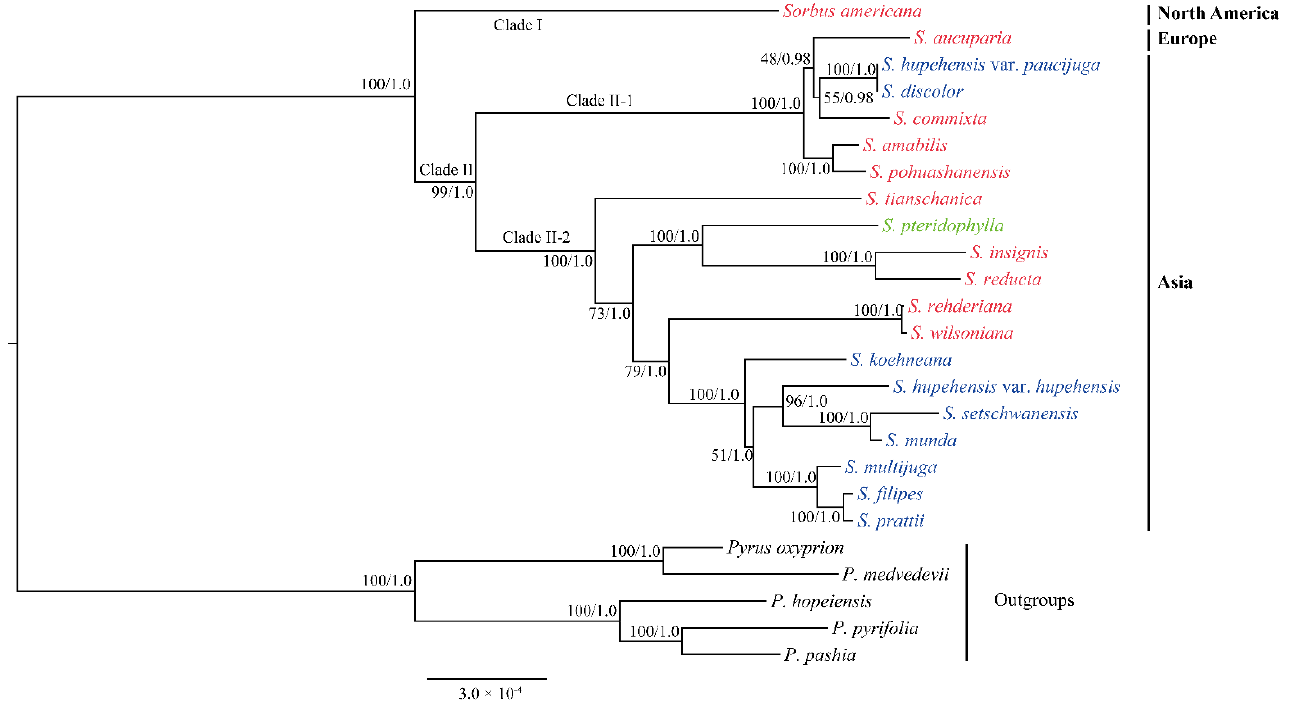
Figure 5. Sliding window analysis of pi values among 20 Sorbus species. X ‐ axis, position of the midpoint of a window; Y ‐ axis, nucleotide diversity of each window. (Window length: 600 bp, step size: 200 bp).